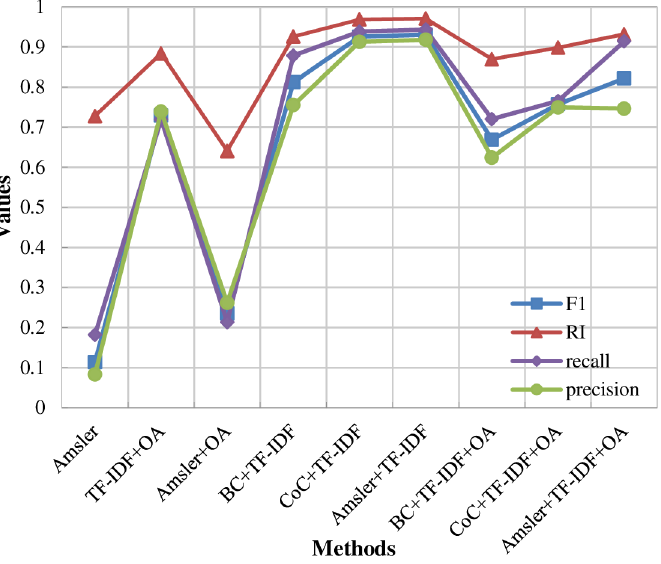
Fig 5. Values of evaluation measuresof different methods. The evaluationmeasures are precision, recall, F1 measure, and RI values, and the different methods are the models listed in Table 3.